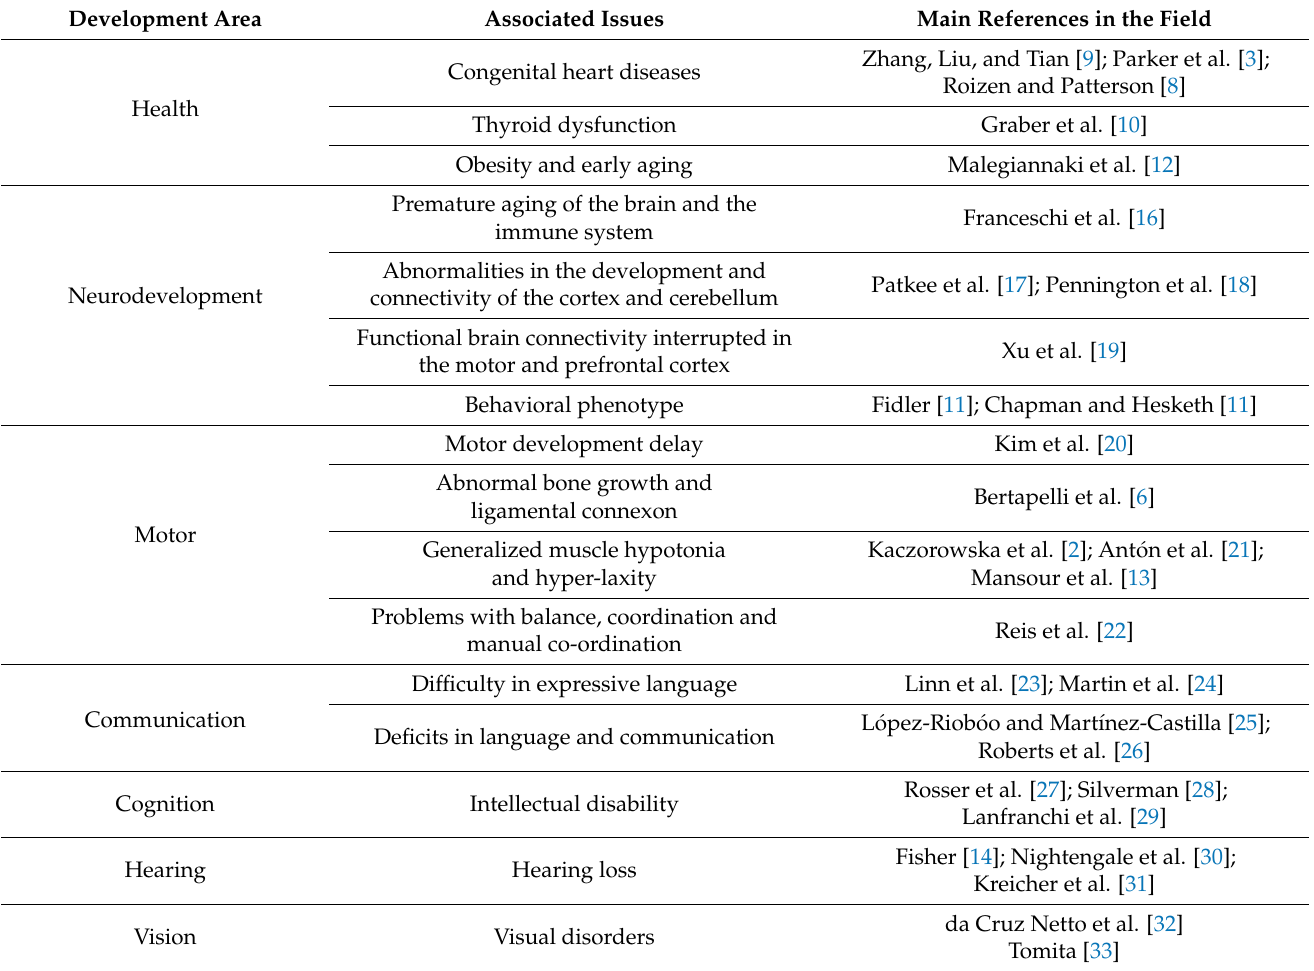
Table 1. Summary of the main developmental characteristics of individuals with Down